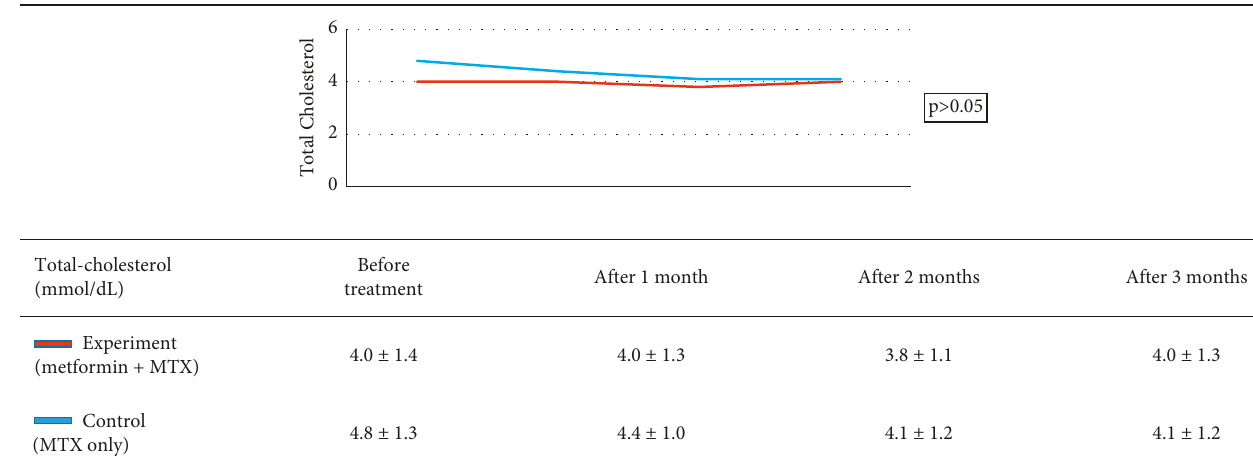
Table 10: Comparison of treatment results of two groups according to total cholesterol.